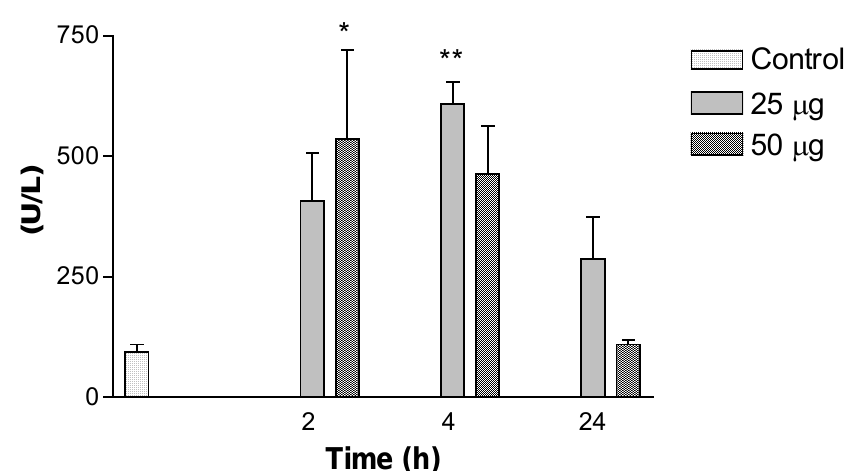
Figure 2. Variations in aspartate aminotransferase (AST/GOT) levels in mice intraperitoneally injected with 25 or 50 μ g of Bothrops jararacussu venom diluted with 0.1ml PBS. Each bar represents the mean and vertical lines, the standard error of mean (S.E.M.) of results obtained from 6 animals.